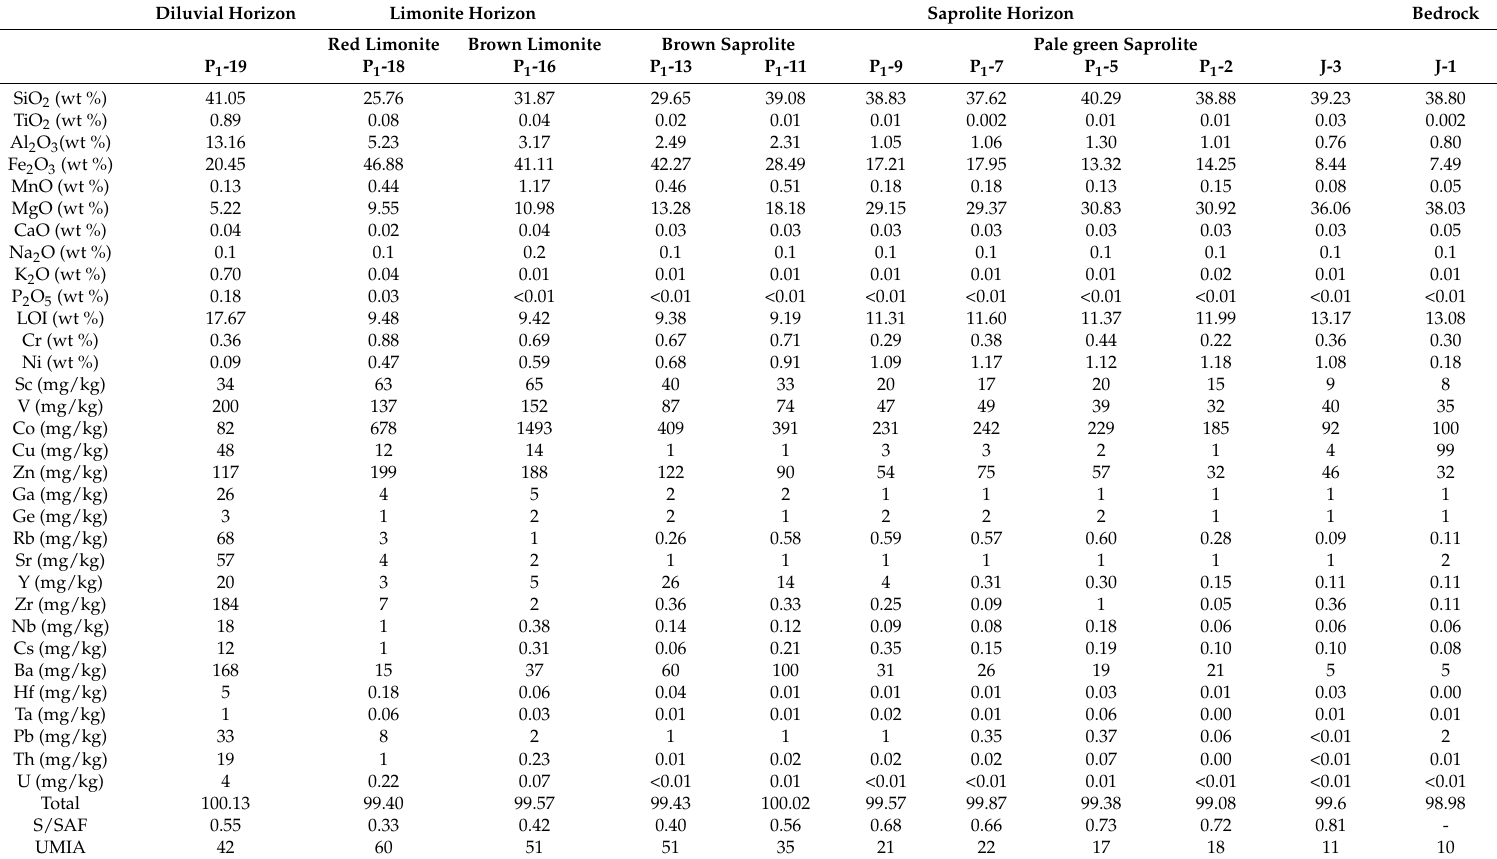
Table 1. Whole-rock analyses data of the samples from the Yuanjiang Ni laterite profile, including major element (wt %) and trace element (in mg/kg). Diluvial Horizon Limonite Horizon Saprolite Horizon